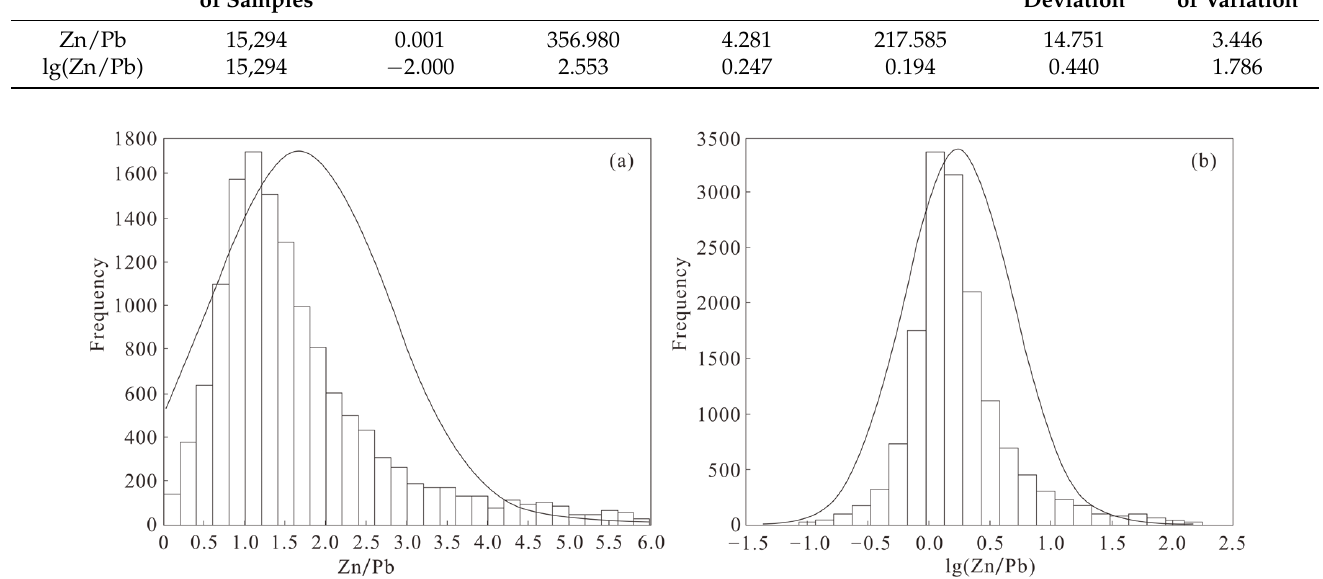
Figure 8. Frequency histograms of Zn/Pb ( a ) and lg(Zn/Pb) values ( b ).